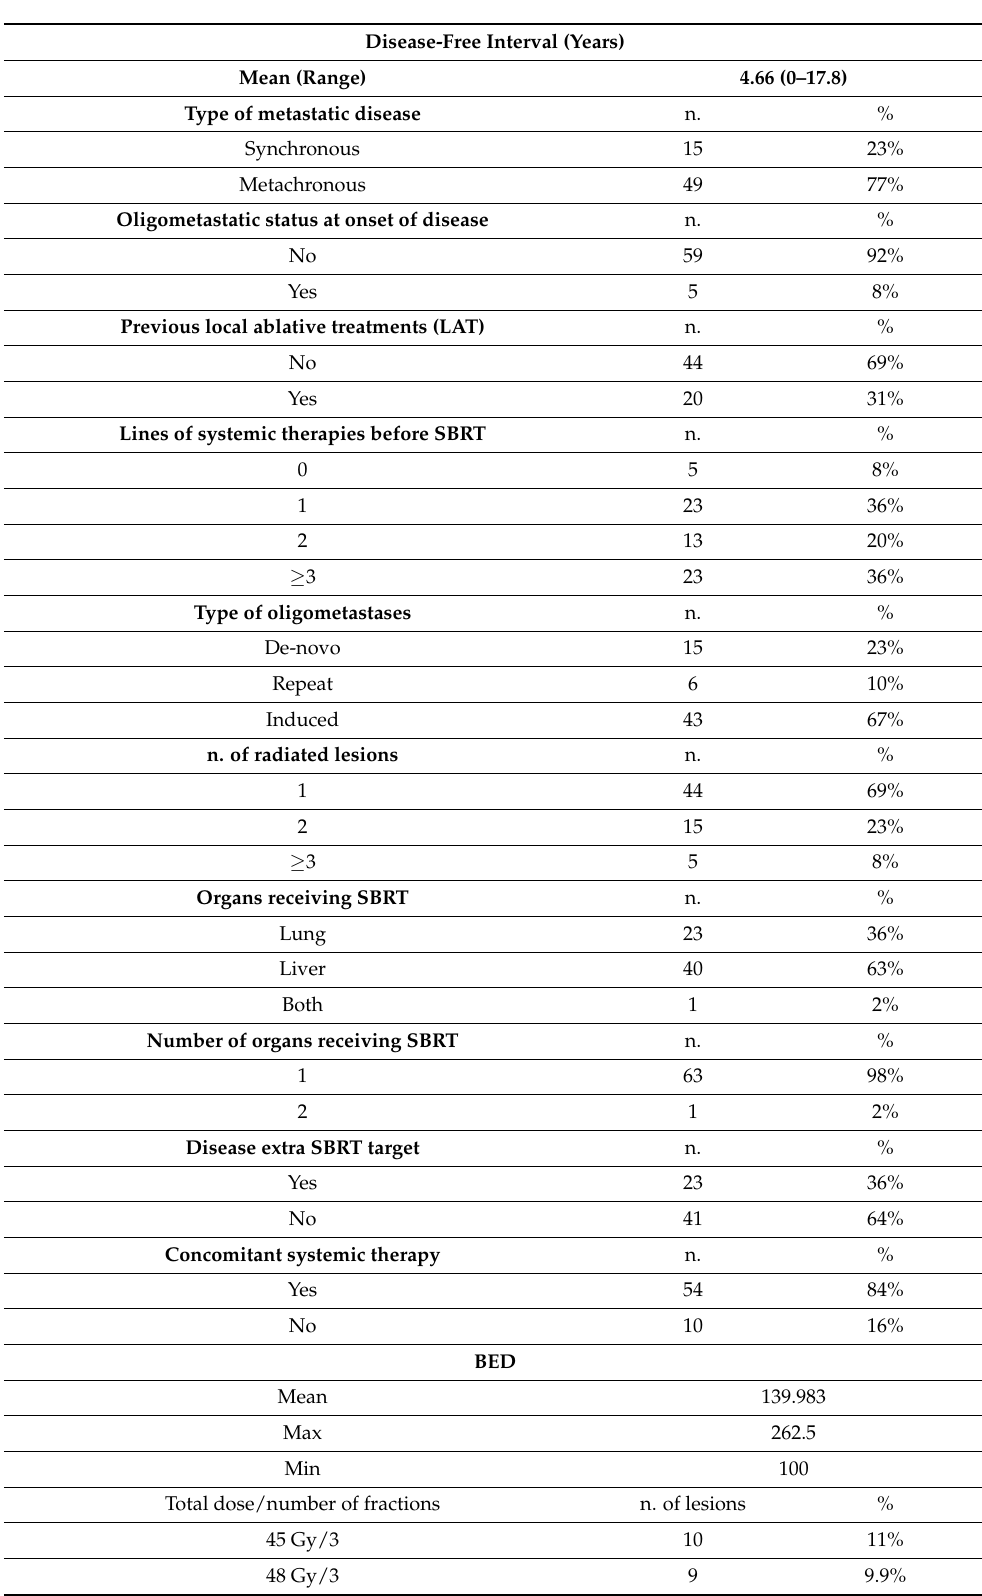
Table 4. Metastatic disease and SBRT